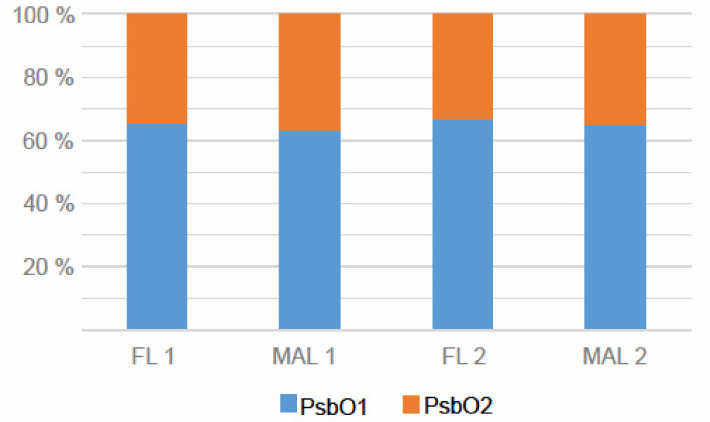
Figure 3. Estimation of PsbO1 and PsbO2 contents in lumen fractions. The relative abundances of PsbO1 (blue) and PsbO2 (orange) in the free lumen (FL) and membrane-associated lumen (MAL) frac- tions were quantified by selected reaction monitoring of their proteotypic peptides (Supplementary Table S4). Analyses of two biological replicates of each fraction are